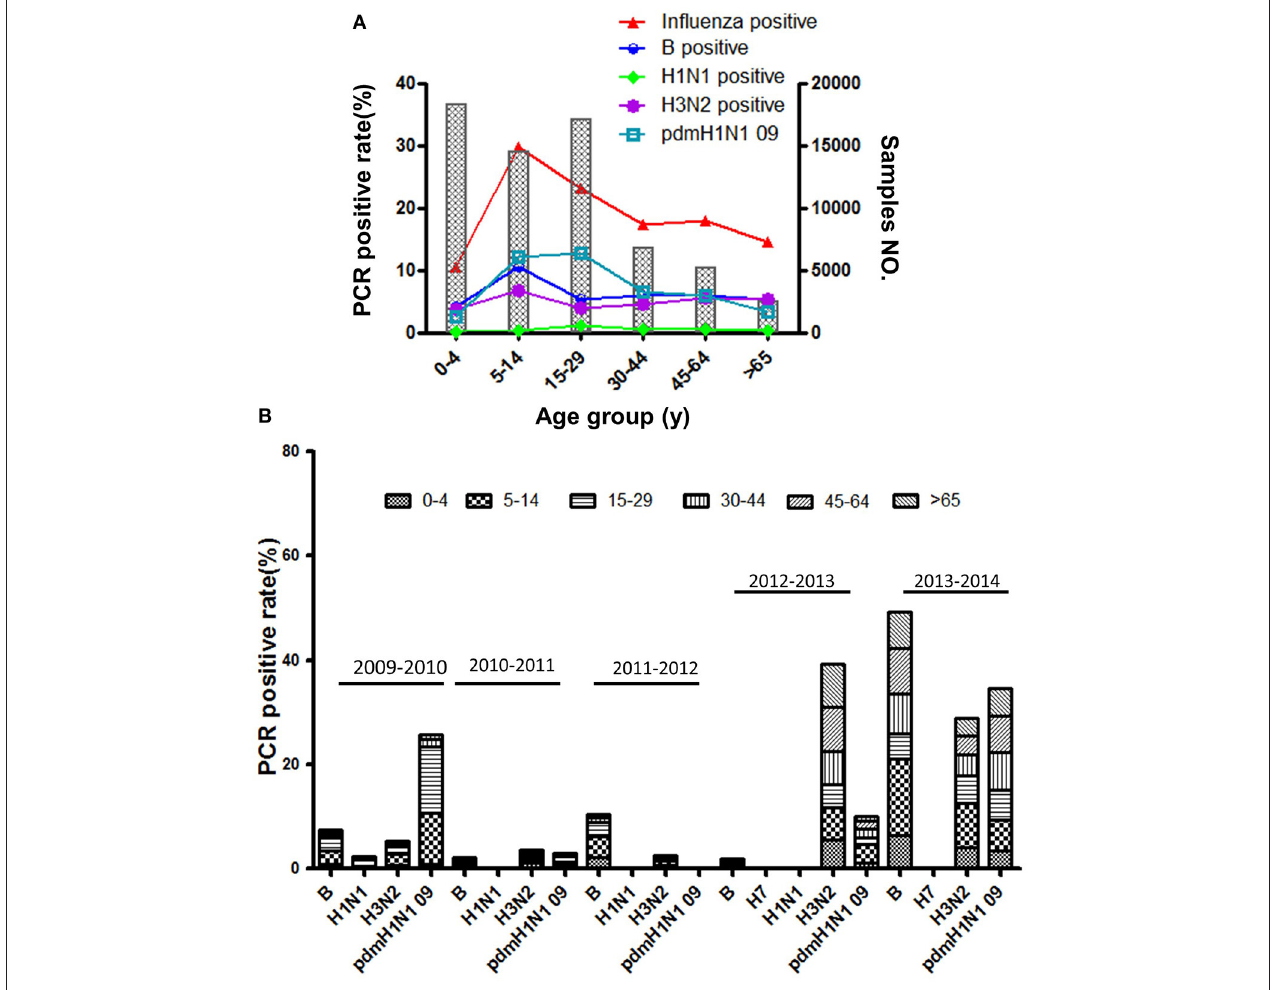
FIGURE 3 | (A) The positive rate of different influenza subtypes by age group. (B) The age composition ratio of different influenza subtypes from 2009 to 2014.